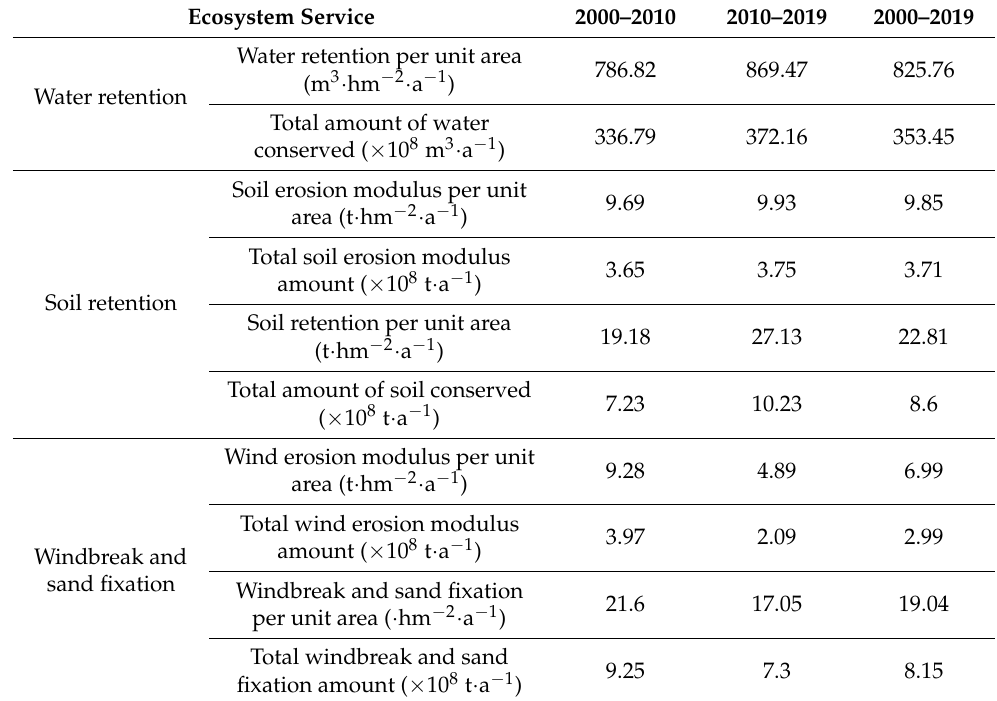
Table 4. Annual mean values of ecosystem services in the Upper Yellow River region.